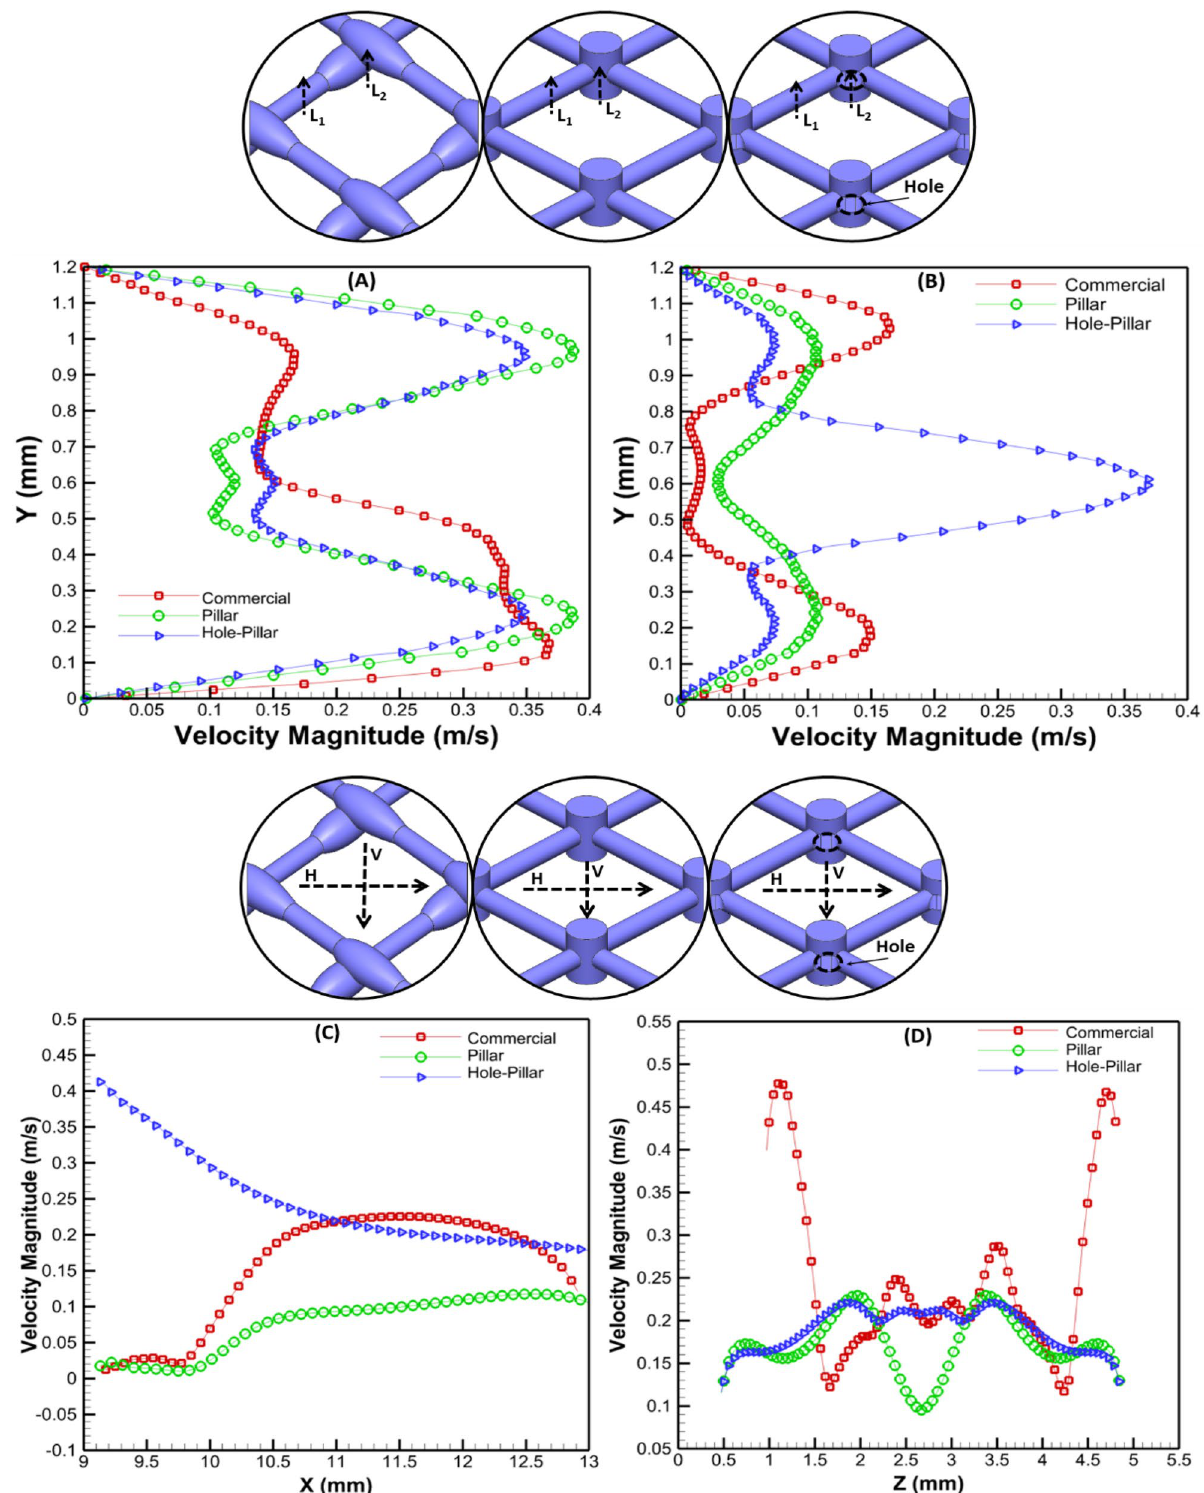
Figure 5. Velocity magnitude profiles computed using DNS computations at different locations: ( A ) Line L 1 (from the bottom wall of the filtration channel to the top wall), ( B ) Line L 2 (from the bottom wall of the filtration channel to the top wall), ( C ) Line H (from the left of the unit flow cell to the right), and ( D ) Line V (from the top wall of the channel to the bottom wall) for the three spacer designs at U o = 0.185 m/s. Boundary layer profiles (L 1 and L 2 ) and spatial profiles (V and H) clearly indicate formation of jets and higher local velocities achieved inside the spacer filament for the hole-pillar spacer compared to the commercial and pillar